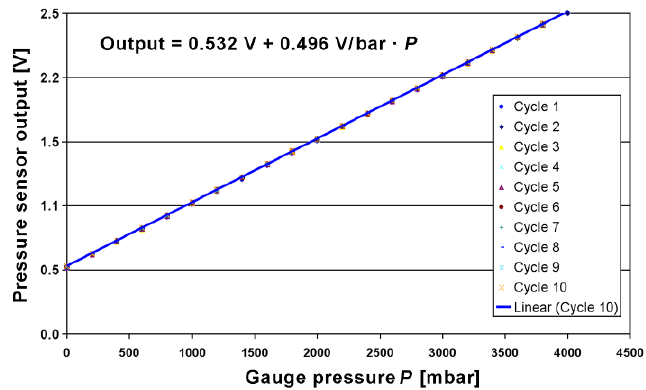
Figure 14. Pressure sensor voltage output vs. gauge pressure for 10 cycles between 0 and 4 bar.